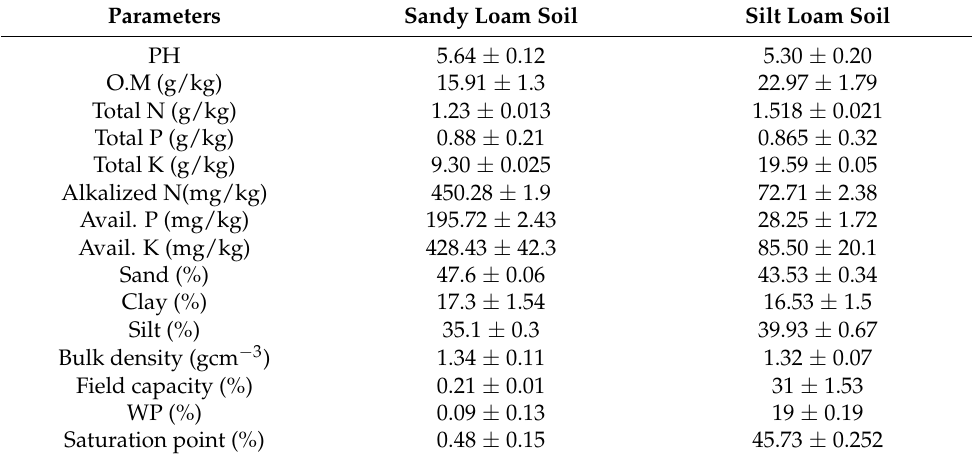
Table 1. Soil physicochemical parameters of the experimental site at a depth of (0–30